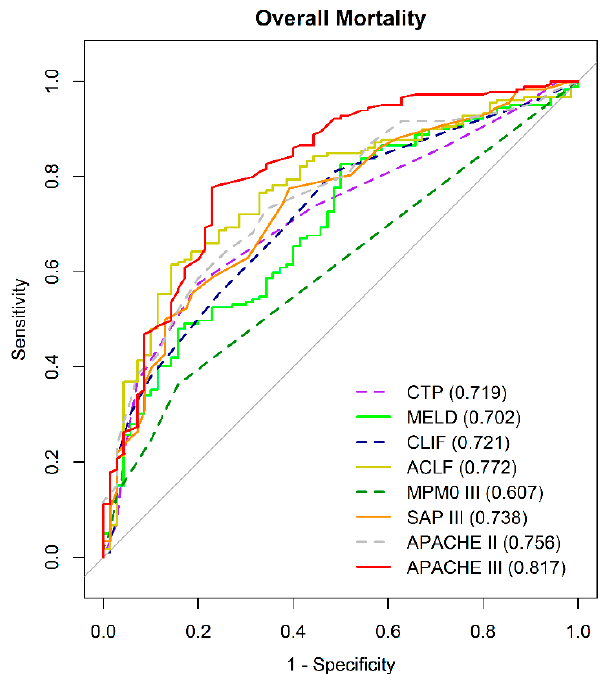
Figure 2. Comparison of the 8 prognostic scores to predict overall mortality by AUROC at specific time point.